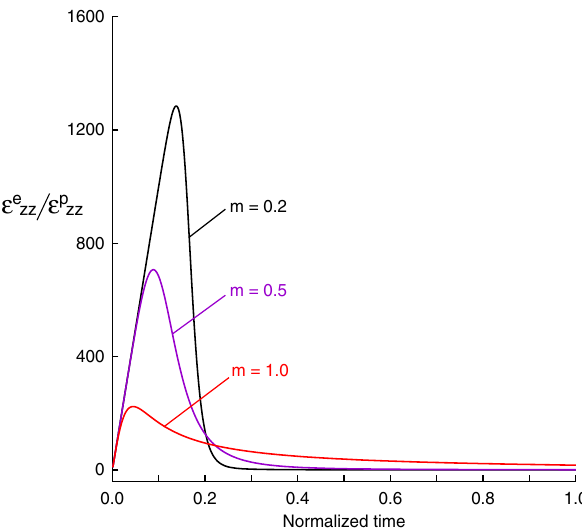
Fig. 7. Time dependence of the kinetic energy and kinetic power for a loading rate given by Eq. (1).